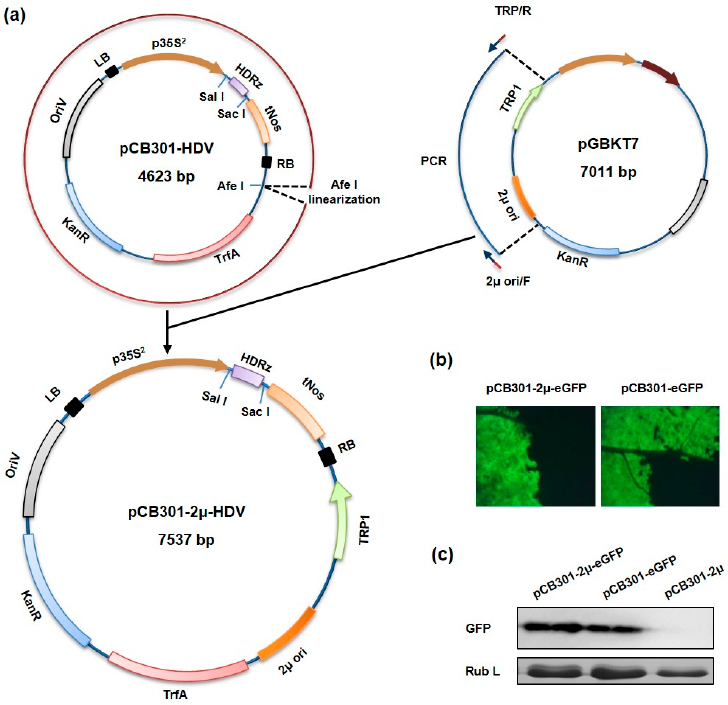
Figure 1. Construction of a yeast- Escherichia coli - Agrobacterium tumefaciens shuttle vector: ( a ) Schematic diagram illustrating construction of the shuttle plasmid pCB301-2 µ -HDV. A fragment containing the yeast 2 µ replication origin and TRP1 selection marker gene was amplified from the yeast plasmid pGBK-T7 with primers TRP/R and 2 µ -ori/F and then inserted into the pCB301-HDV Agrobacterium binary vector through the AfeI restriction site. p35S 2 , doubled CaMV 35S promoter; ( b ) Transient expression of eGFP in agroinfiltrated leaf patches. Nicotiana benthamiana leaves were infiltrated with Agrobacterium mixtures carrying the pCB301-2 µ -eGFP or pCB301-eGFP plasmid and the TBSV p19 suppressor plasmid. The infiltrated leaves were visualized under a fluorescence microscope at 36 h post infiltration; ( c ) Total proteins extracted from infiltrated leaf patches were analyzed in a Western blot with an eGFP-specific antibody. TRP1 : tryptophan selection maker gene; OriV: RK2 replication origin; TrfA: replication initiator protein; HDRz: HDV ribozyme; tNos: Nos terminator; 2 µ ori: yeast 2 µ replication origin; KanR : kanamycin resistance gene; LB: left border sequence; RB: right border sequence; eGFP: enhanced green fluorescence